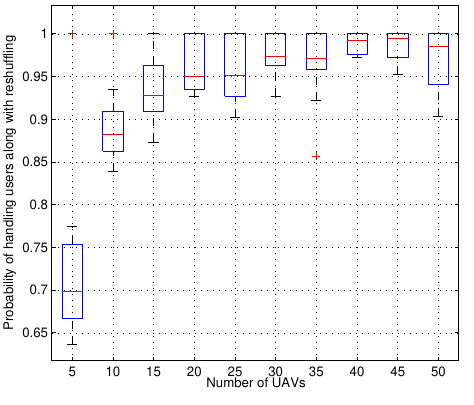
Figure 5. Probability of handling users with reward-based reshuffling vs. number of UAVs.